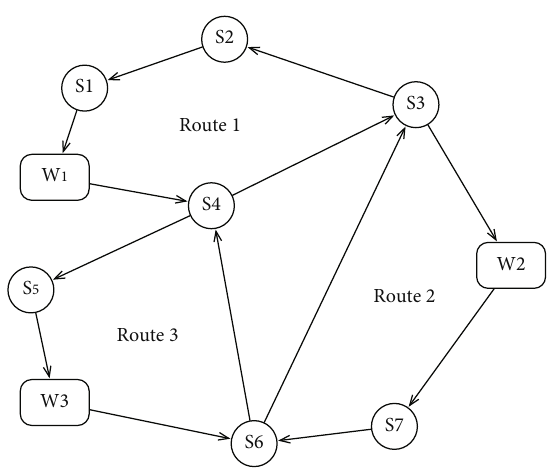
Figure 2: An example of MD-CVRP-OSA vehicle